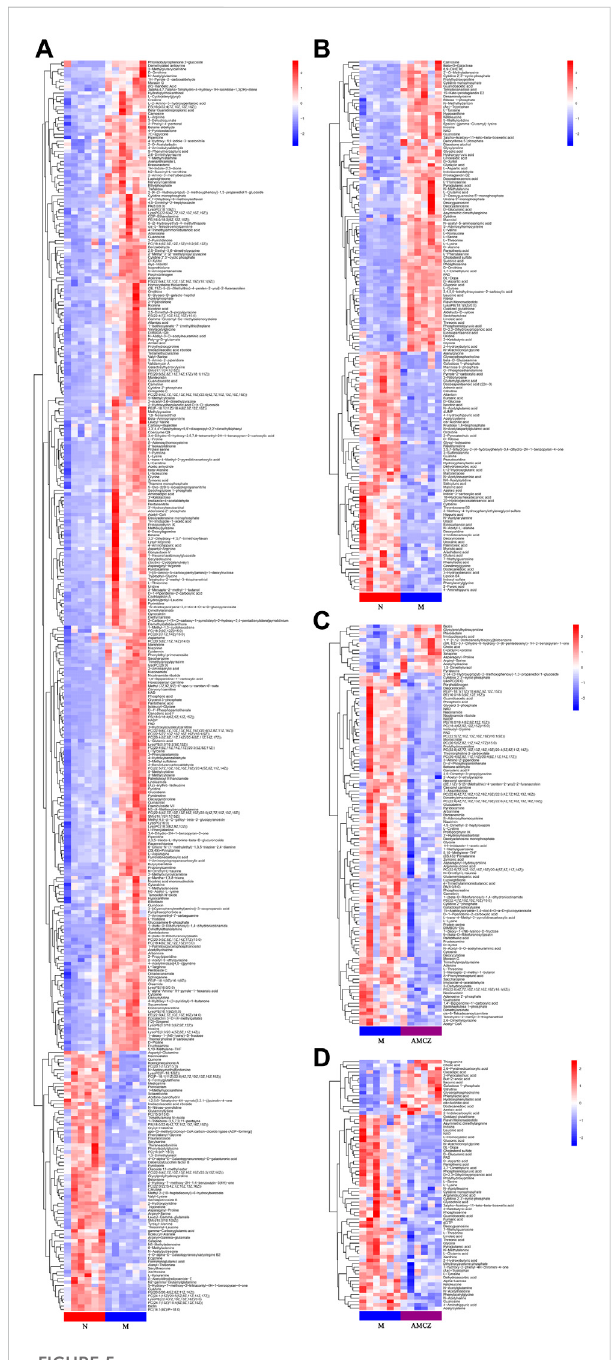
FIGURE 5 Heatmap of hierarchical clustering analysis of the differential metabolites. Comparison between N and M in positive (A) and negative (B) ion mode. Comparison between M and AMCZ in positive (C) and negative (D) ion